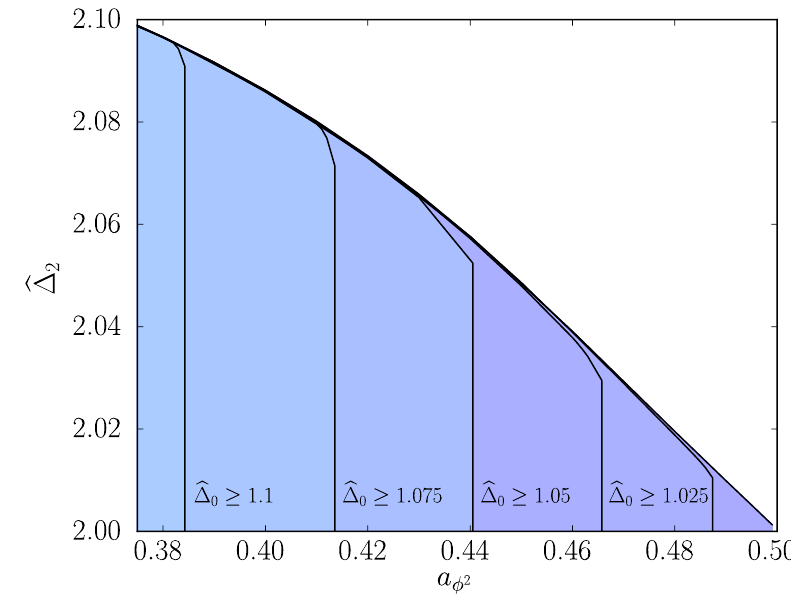
Figure 3. The maximum spin 2 gap, as in the previous figure, except with scalar gaps of 1 . 025 , 1 . 05 , 1 . 075 , 1 . 1 and 1 . 125 . The upper bound on b ∆ within one of these regions is no longer the 2 same as the upper bound for the b ∆ = 1 region. While it is possible that the upper right corners 0 still correspond to minimal model boundary conditions, it is curious that this effect occurs in the part of the plot where non-unitarity is expected to be most